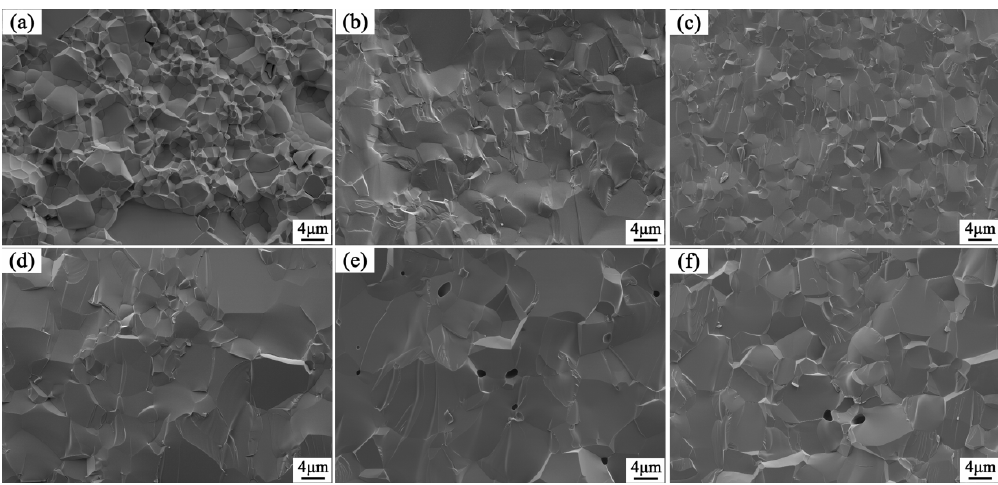
Fig. 14 Fracture surfaces of La 2– x Gd x Hf 2 O 7 transparent ceramics: (a) x = 0; (b) x = 0.4; (c) x = 0.8; (d) x = 1.2; (e) x = 1.6; and (f) x = 2.0. Reproduced with permission from Ref. [44], © Elsevier B.V. 2015.